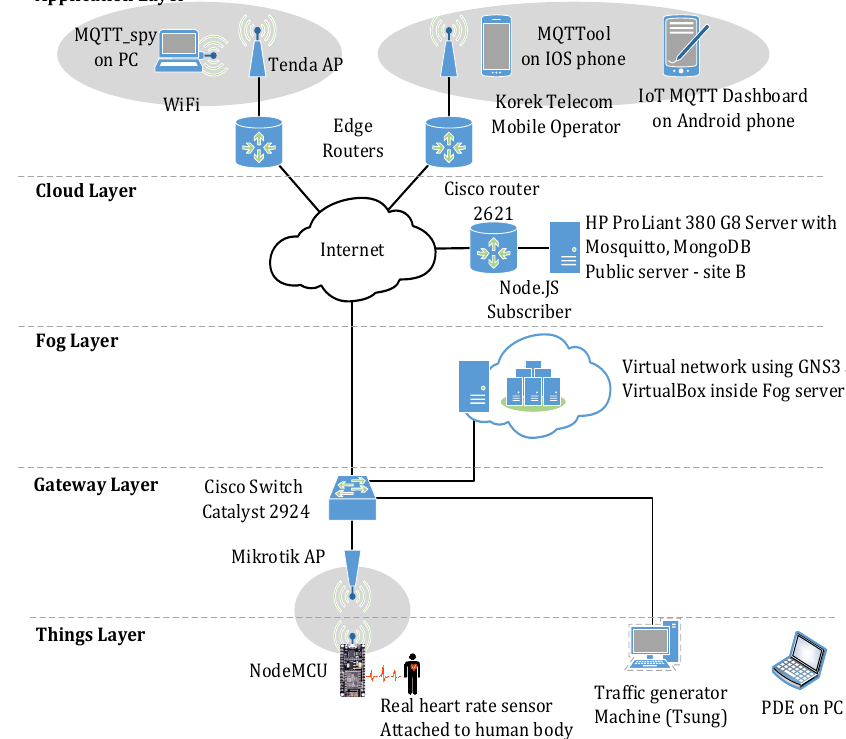
Figure 9. Proposed IoT-F2CDM-LB architecture with SLB load